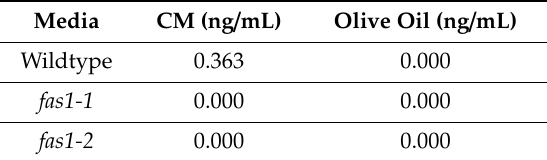
Table 1. Fatty acid synthase activity in wildtype and mutant M. oryzae strain S6 of two biological and then transferred to MM containing 50 mM of olive oil for 24 h before